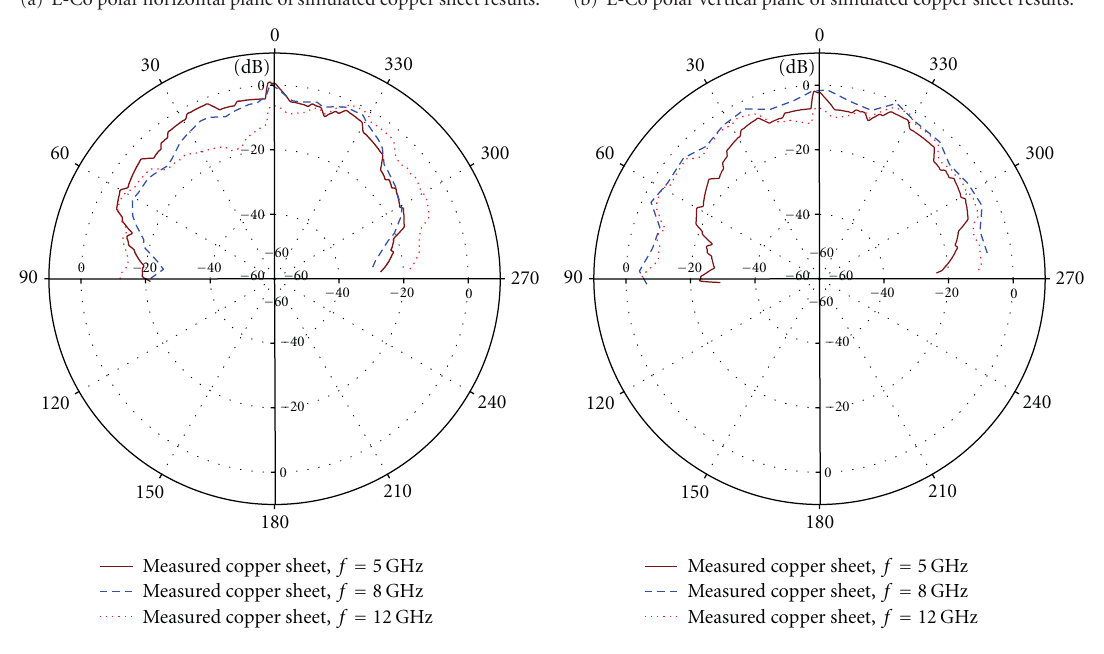
(b) E-Co polar vertical plane of simulated copper sheet results.